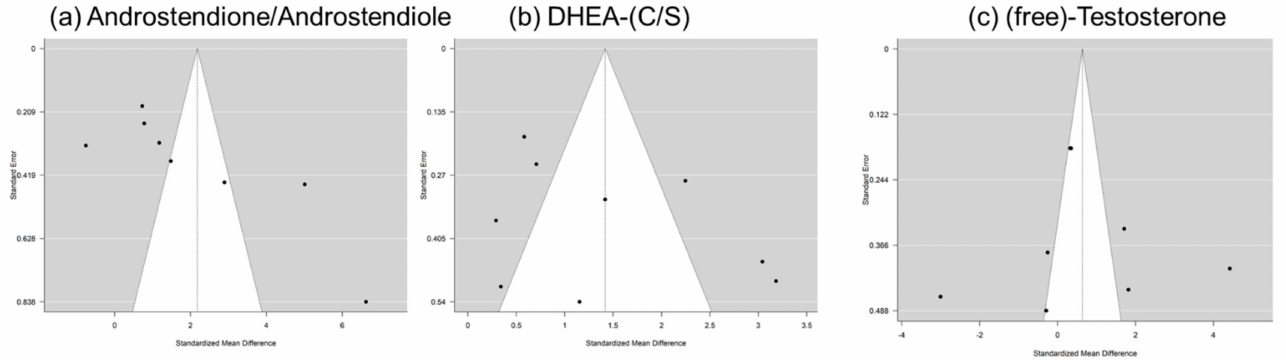
Figure 5. Funnel plots for boys: x -axis—standardized mean difference; y -axis—standard error for ( a ) androstene- dione/androstenediol, ( b ) DHEA-(C/S), and ( c ) (free) testosterone.